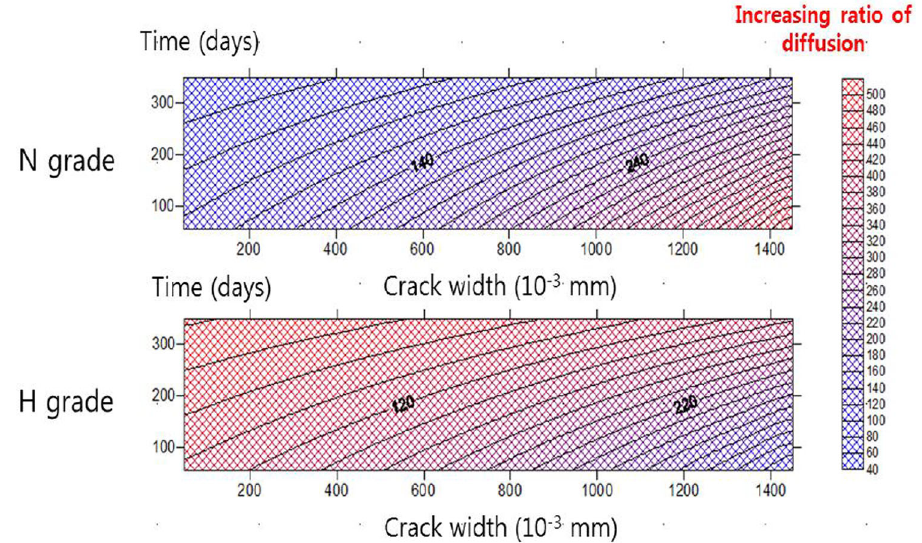
Fig. 9 Diffusion coefficient contours with time and age